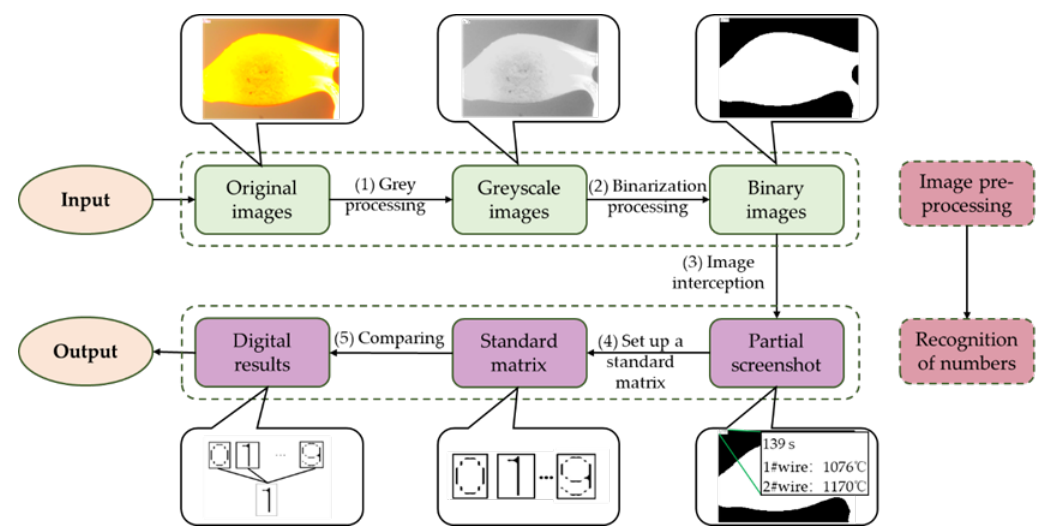
Figure 3. Diagram showing steps of extracting temperature information from an image.